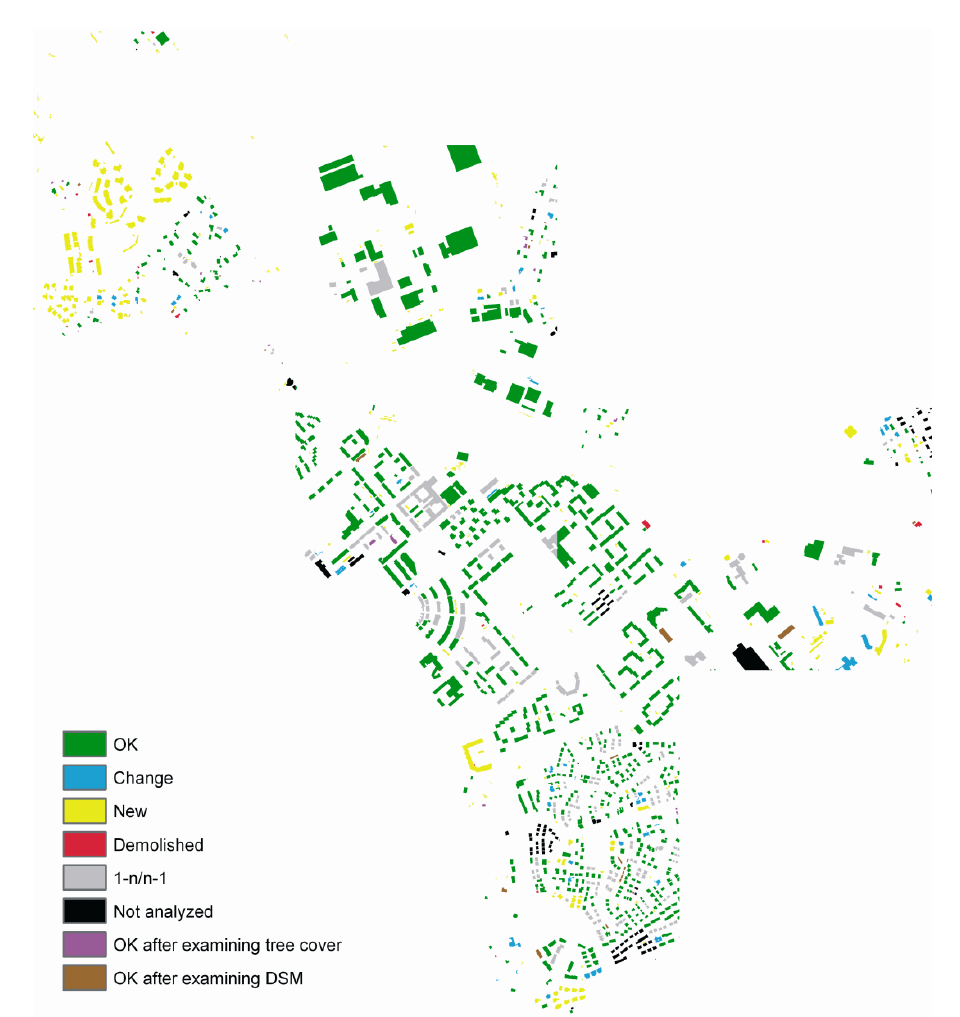
Figure 7. Change detection results for the test areas (overlap approach used). New and changed buildings were taken from the building detection results, others from the old building map. Buildings of the old map  The National Land Survey of Finland 2001, permission number